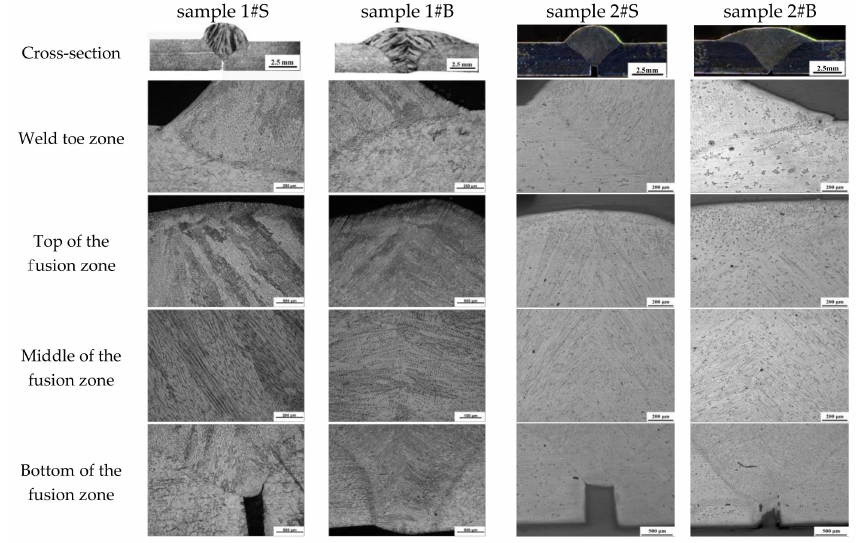
Figure 7. Microstructures of butt welds formed at high-speed